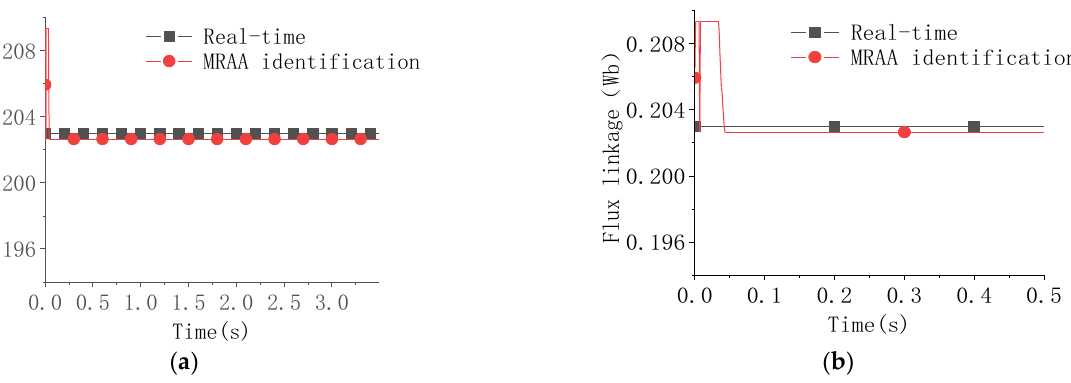
Figure 10. Comparison between the MRAA-identified flux linkage and actual flux linkage. ( a ) Com- parison of flux linkage and ( b ) the local magnification of the anterior segment.